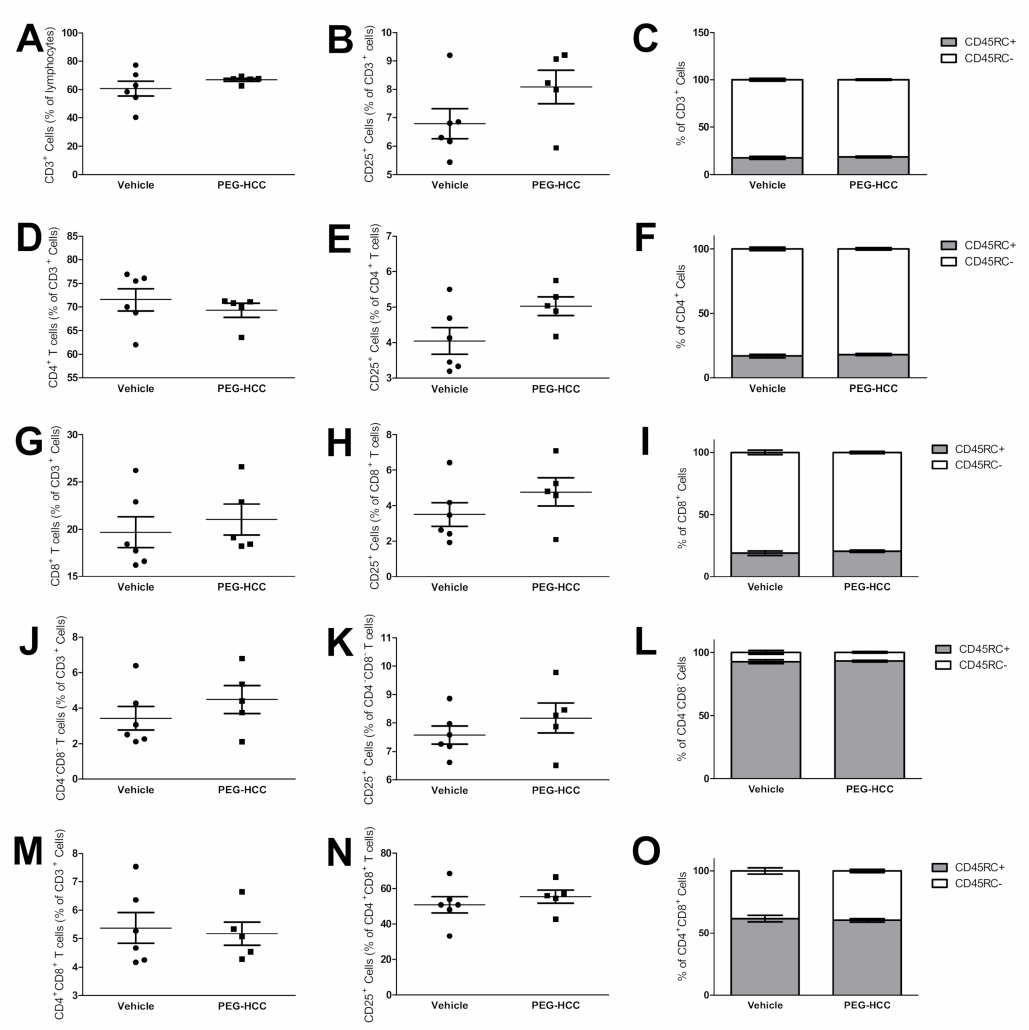
Figure 7. PEG-HCCs do not alter T cell populations in the lymph nodes during PIA. ( A – O ) Expression of CD3, CD4, CD8, CD25, and CD45RC of cells in the inguinal lymph nodes of rats with PIA treated with either vehicle ( n = 6) or PEG-HCCs ( n = 5) for twenty days after disease onset. Data are presented as mean ±